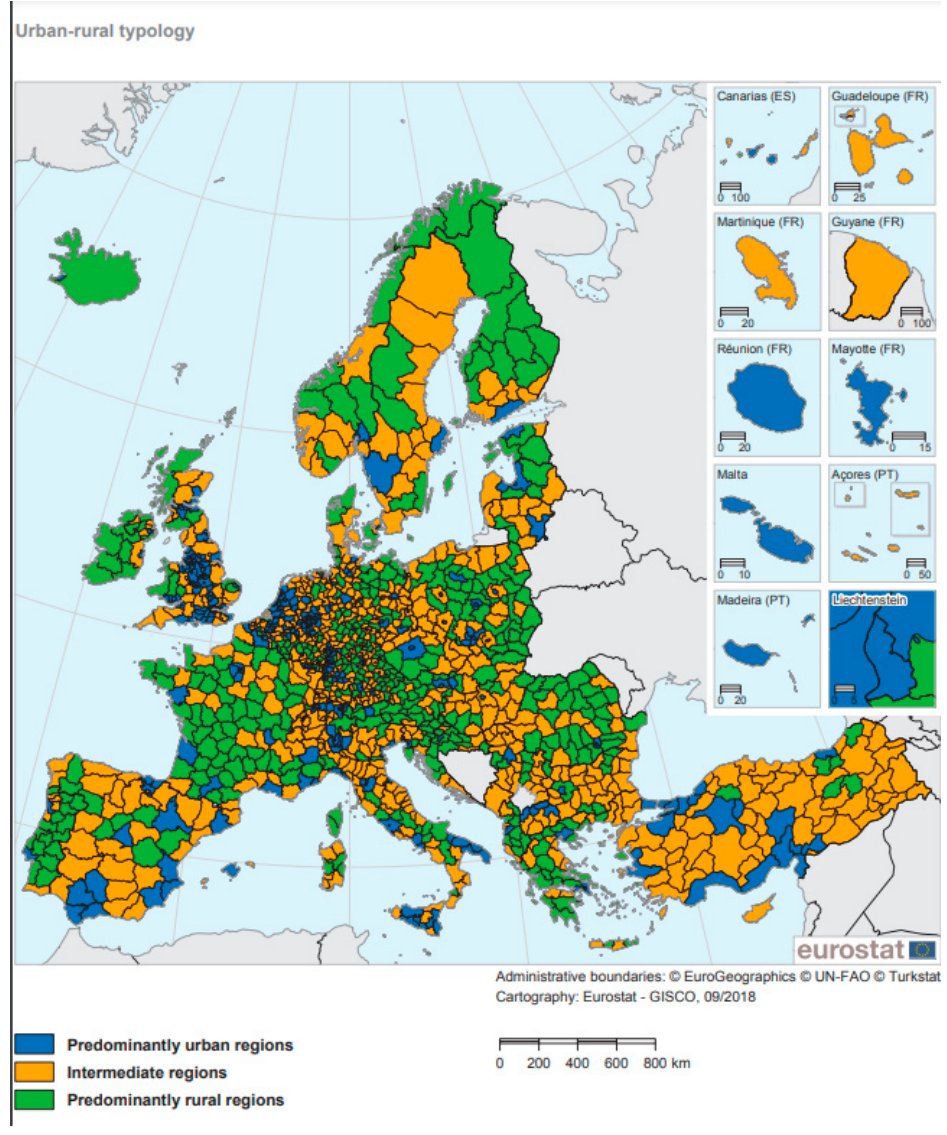
Figure 1. The representation of Europe and Italy after applying the Tercet classification, Urban– Figure 1. rural typologies.